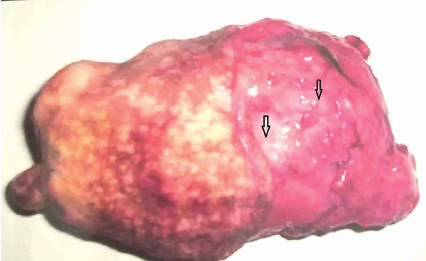
Figure 3: Gross appearance of resected mammary tumor showing ulcerative and hemorrhagic spots on surface weighing about 850gm.